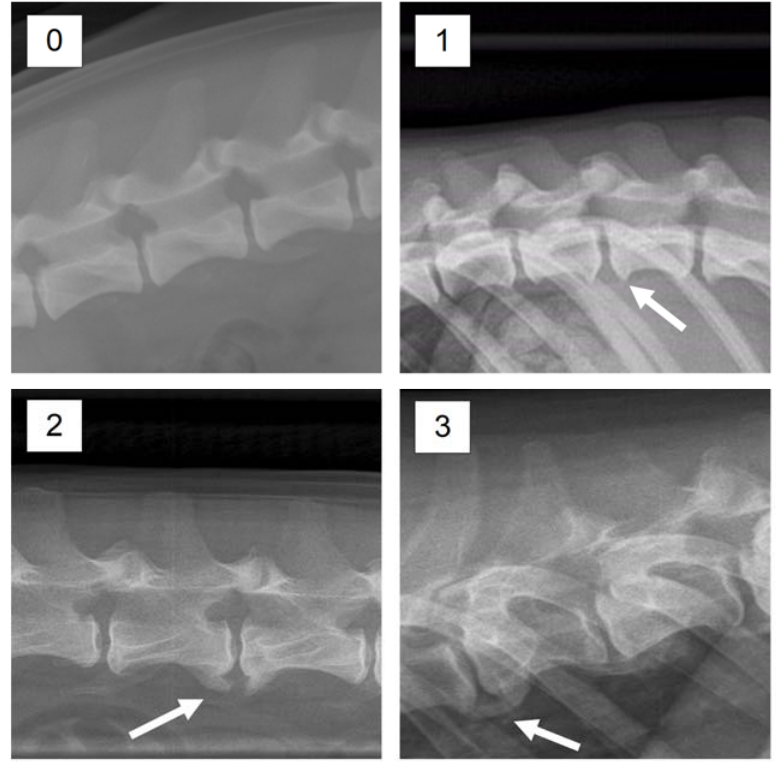
Figure 2. X-ray images with examples of enthesophyte development corresponding to the scores 0– 3.